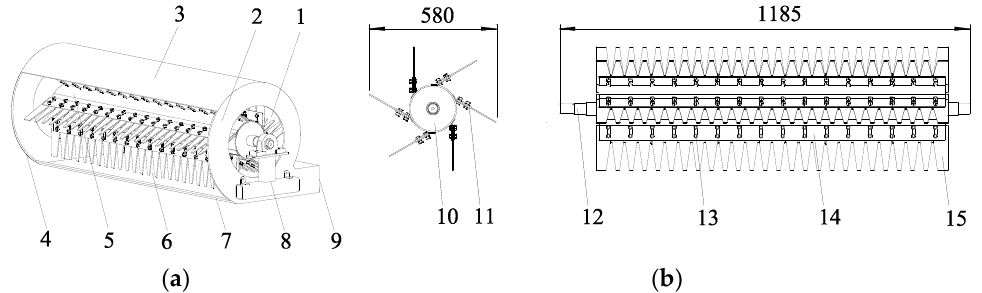
Figure 2. Structural schematic diagram of the film removal device ( a ) and structure diagram of the vane-type film removal roller ( b ). 1. Air inlet. 2. Side plate. 3. Top cover. 4. Diversion shell. 5. Vane type film removal roller. 6. Film removal area. 7. Bottom plate. 8. Frame. 9. Film conveying port. 10.